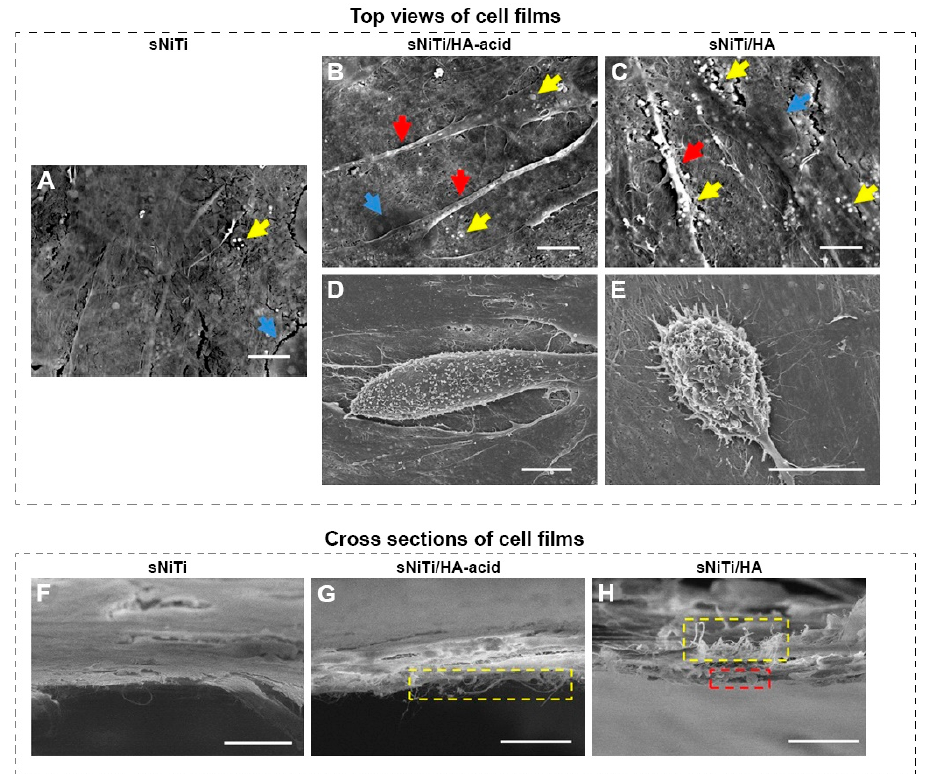
Figure 14. Osteoblast morphology on different sNiTi plates [92].After three days of osteoblast culture, the top view of the cell monolayers was imaged by SEM: ( A ) sNiTi; ( B ) and ( D ) sNiTi / HA-acid; ( C ) and ( E ) sNiTi / HA. Representative areas in ( A – C ) showing mineral deposits (yellow arrows), cell nuclei (blue arrows), and lamellipodia (red arrows). Some cells displayed a dome shape on sNiTi / HA-acid, as in ( D ); and sNiTi / HA, as in ( E ); no similar cells were found for sNiTi. Cross sections of the osteoblast monolayer were also imaged: ( F ) sNiTi; ( G ) sNiTi / HA-acid; ( H ) sNiTi / HA. A fibrous structure which is highlighted by yellow rectangles was observed in ( G , H ) and possibly represents extracellular matrix. The red rectangle in ( H ) indicates possible mineralized microspheres attached to the cell monolayer. Scale bar: 10 µm. Reprinted with permission from reference [92] 2018 Elsevier.